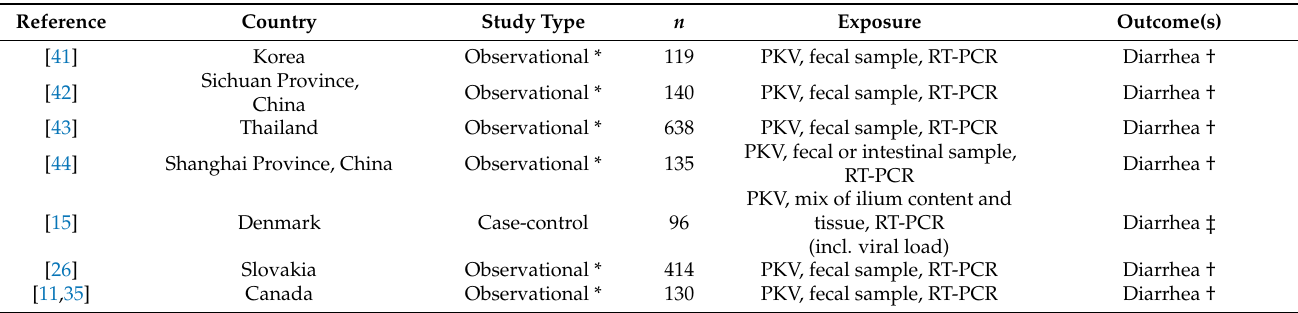
Table 2. Overview of 16 studies included in the systematic review of whether porcine kobuvirus is a cause of gastrointestinal disease in